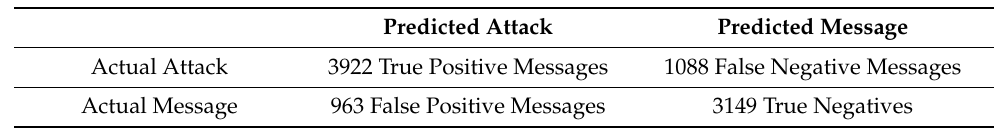
Table 5. Confusion